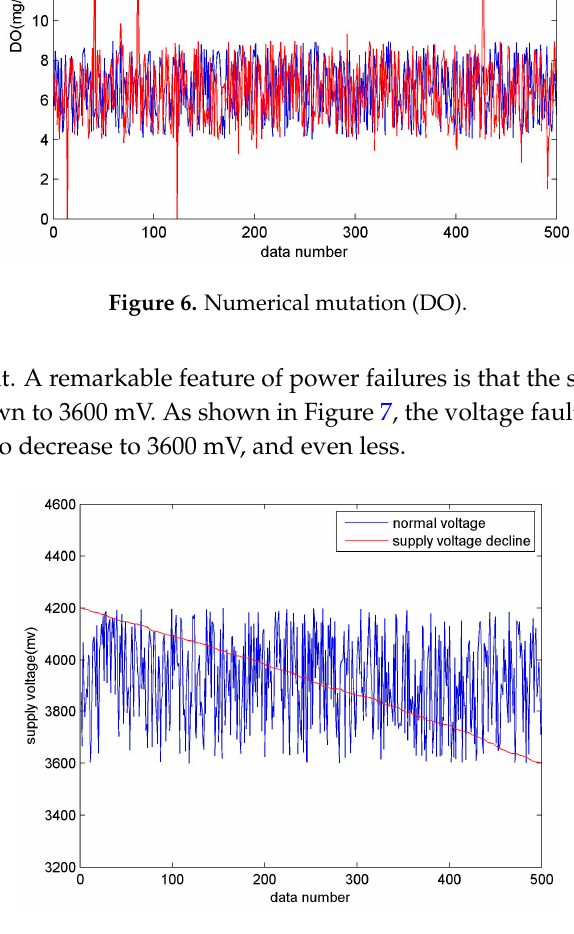
Figure 7. Supply voltage fault.